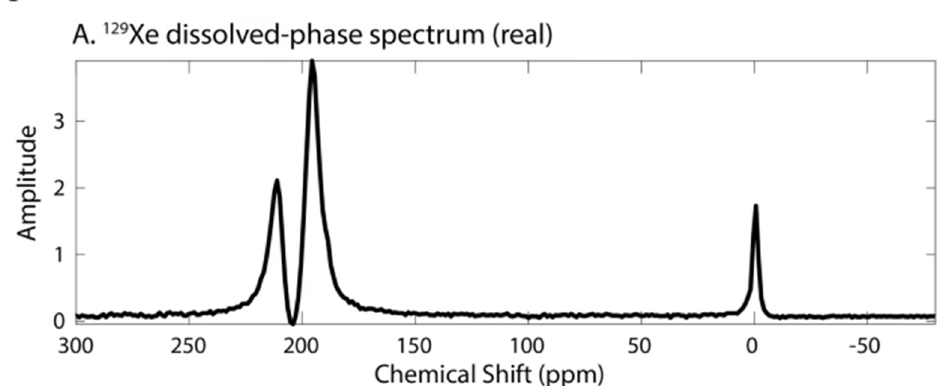
Figure 14. A HXe spectrum acquired in a healthy rat shows three distinct peaks, corresponding to gas in the alveoli/airways (set to 0 ppm), dissolved in tissue and blood plasma (197 ppm) and transiently bound to hemoglobin (~210.5 ppm). In vivo spectra in rats, humans, sheep and goats display distinct dissolved peaks that can be interrogated separately with an appropriate acquisition sequence, while those in pigs, rabbits and mice do not. Because the RF pulse was selective for dissolved components, the peak sizes greatly overrepresent the dissolved fraction.